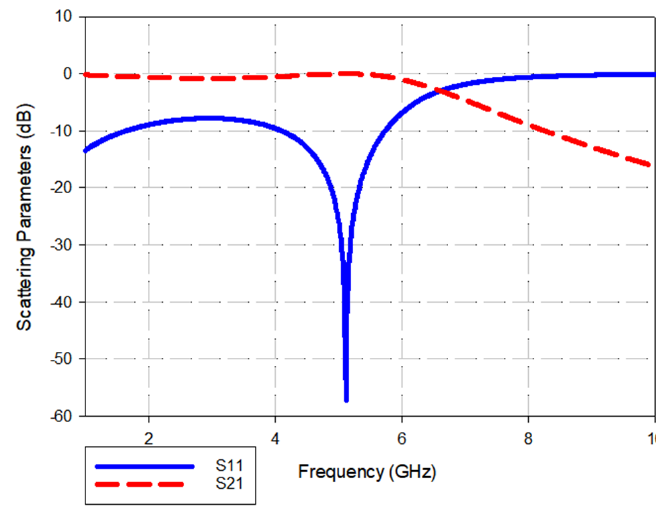
Figure 3. Simulation response of ADS equivalent circuit.